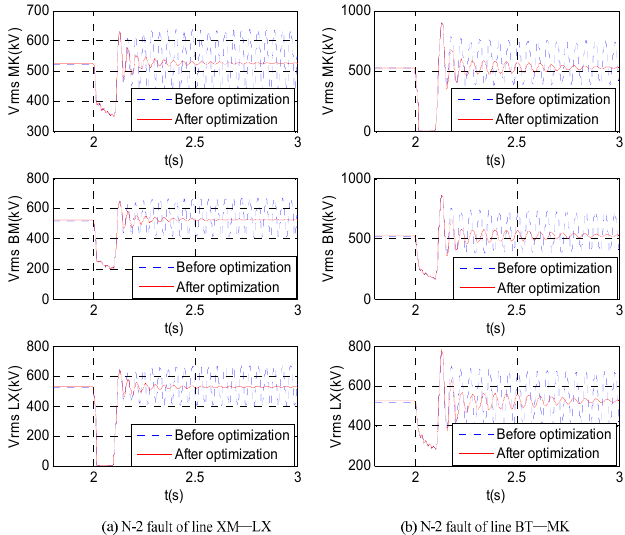
Figure 14. Dynamic response of the system under faults before and after SVC parameter optimization with PSCAD.